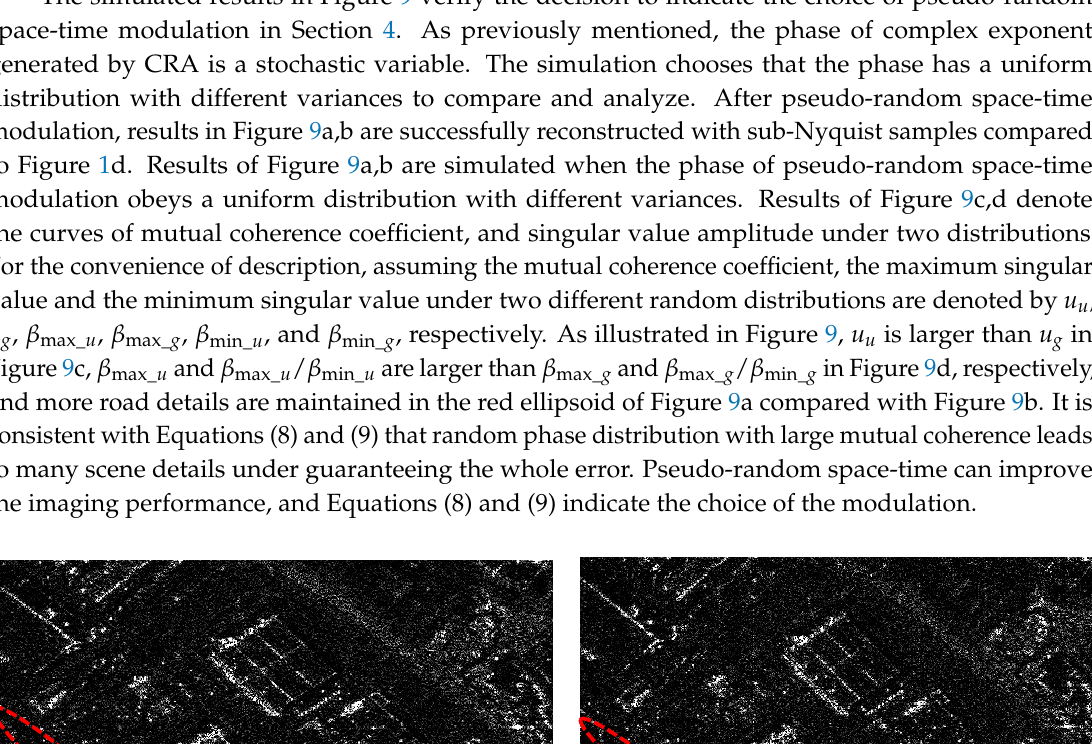
Figure 8. The reconstruction error before and after the pseudo-random time-space modulation.